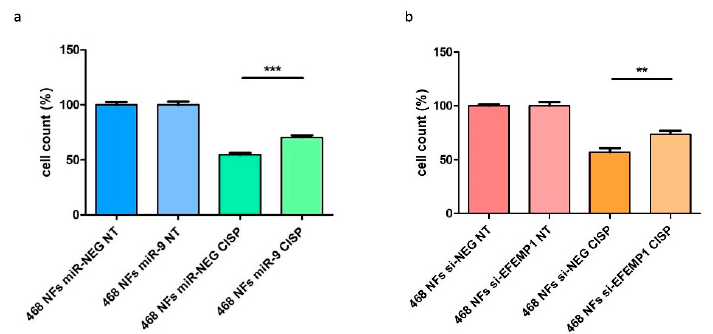
Figure 4. NFs miR-9/siEFEMP1 reduce tumor cell sensitivity to cisplatin. MDA-MB-468 cell count upon treatment with cisplatin (24 h) after 24h of conditioning with the supernatant of ( a ) NFs miR-9 or ( b ) si-EFEMP1, compared to controls. Cell count data are presented as mean of the percentage of ± SEM (** p < 0.01, *** p < viable treated (CISP = cisplatin) cells of three biological replicates, compared to non-treated (NT) cells, ±SEM (** p < 0.01, *** p < 0.001).